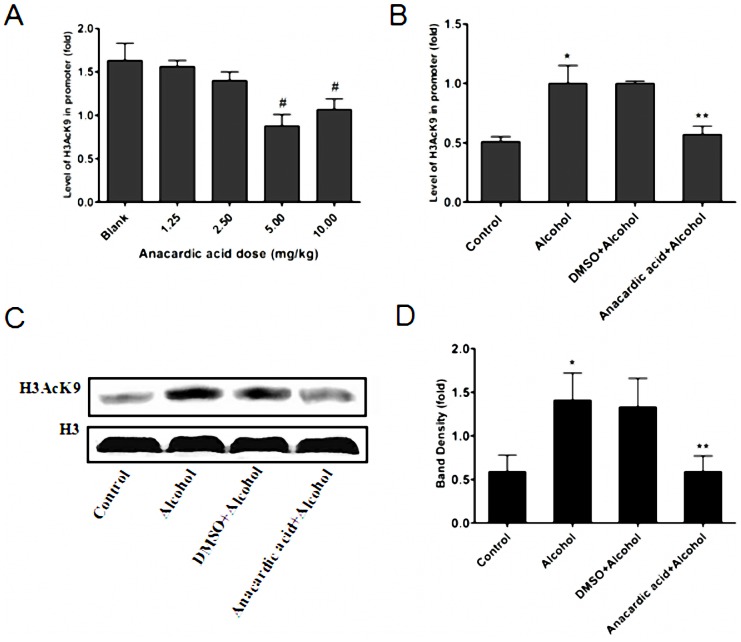
Anacardic acid inhibits histone H3K9 hyperacetylation under alcohol treatment.Pregnant mice were exposed to various portions (0, 1.25, 2.5, 5 and 10 mg/kg) of anacardic acid to ascertain optimal dose. The result showed that the level of H3AcK9 on the Gata4 promoter after intraperitoneal injection with 5 mg/kg anacardic acid was the lowest compared with another dose. #: P<0.05 vs. blank group (n = 3) (A). ChIP-Q-PCR results further confirms that anacardic acid (5 mg/kg) could reduce significantly hyperacetylation of histone H3K9 induced by alcohol on the Gata4 promoter at E14.5. *: P<0.01 vs. control group (n = 3), **: P<0.01 vs. alcohol group (n = 3) (B). Western blot analysis showed that the anacardic acid (5 mg/kg) could inhibit significantly hyperacetylation of histone H3K9 in the myocardium. *: P<0.01 vs. control group (n = 6), **: P<0.01 vs. alcohol group (n = 6). (C): band density, (D): statistic analysis.